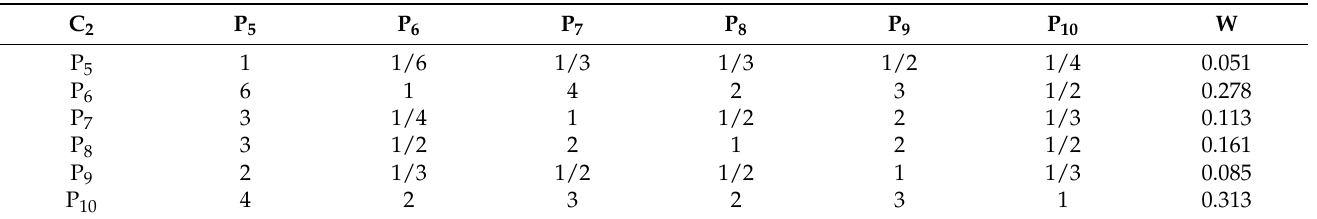
Table 8. The results of matrix and its consistency test between Constraint layer (C 2 ). and Standard layer (P 5 –P 10 ).